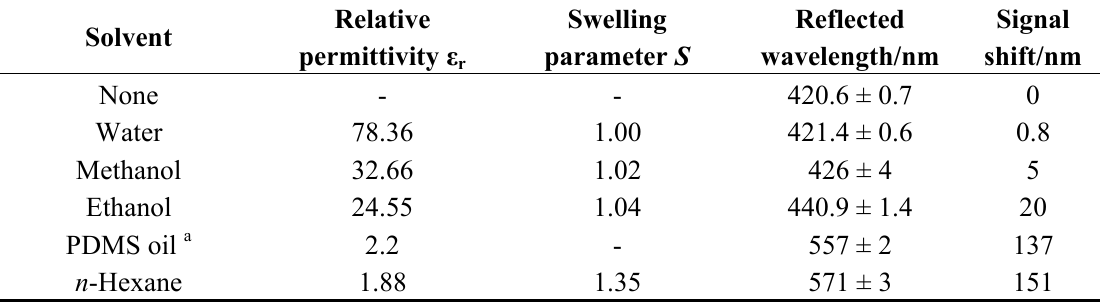
Table 1. Reflected light of a thin film composed of polystyrene nanoparticles in polydimethylsiloxane in the presence of different solvents. The data for the relative permittivity of PDMS were taken from reference [31], those for the other solvents from reference [32]. The swelling parameters S , defined as the ratio of the polymer length in